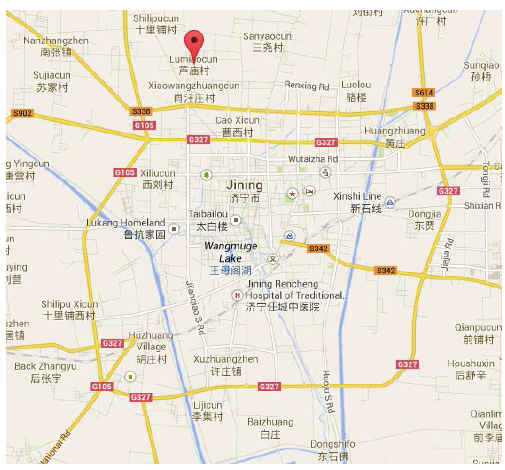
Figure 3: Location of Daizhuang Coal Mine in